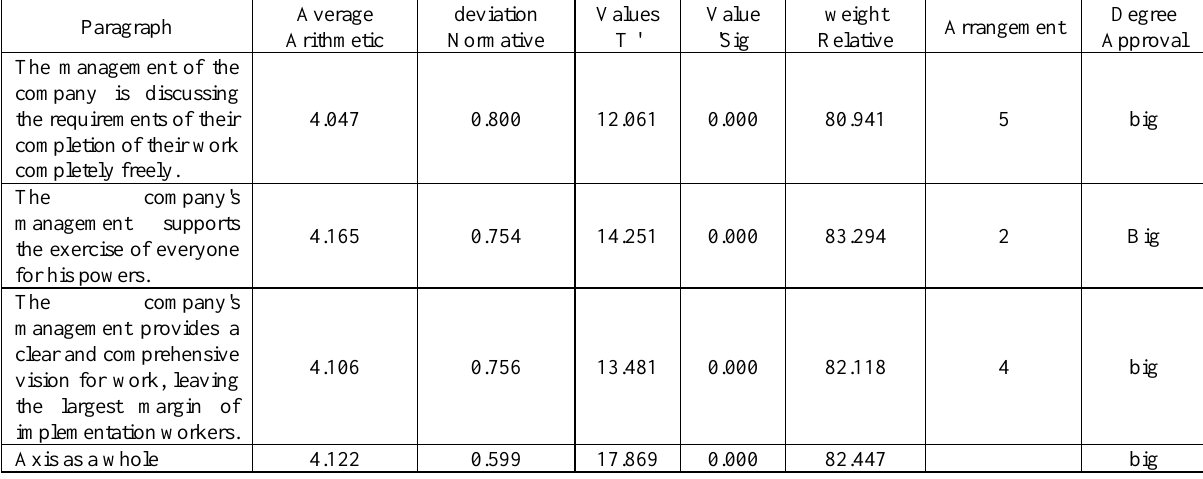
Table 14 (cont.). Analysis of the paragraphs of the axis of freedom and independence